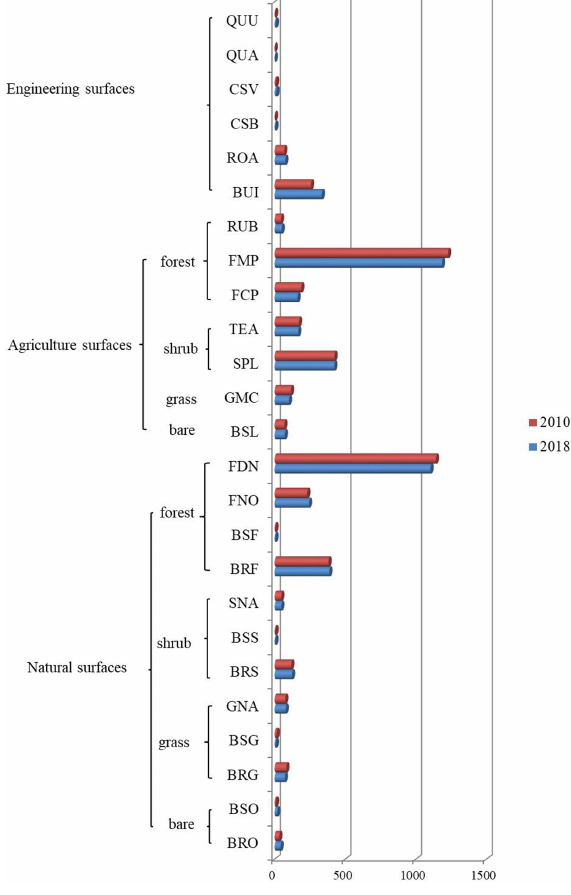
Figure 16. General land use types of all landslides in Kerala: